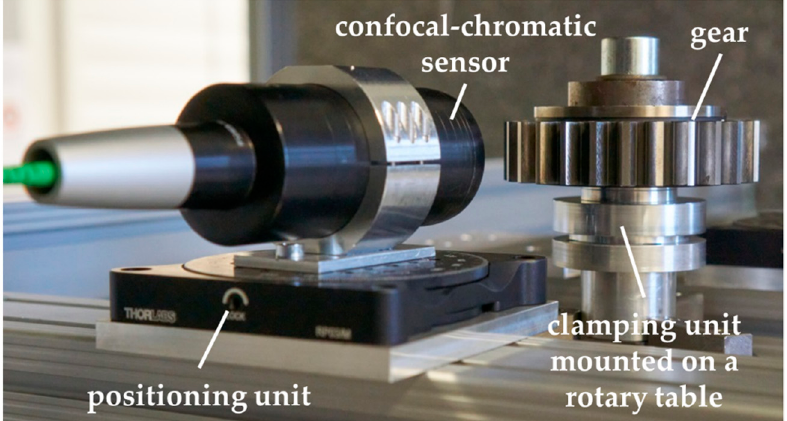
Figure 4. Experimental set-up for model-based scanning single-sensor multi-distance gear measurements of the mean base circle radius of a non-modified involute spur gear with a nominal base circle radius of 45.8100 mm. The single-sensor approach consists of a confocal-chromatic distance sensor and a rotary table to perform scanning measurements of the tooth flank contours.